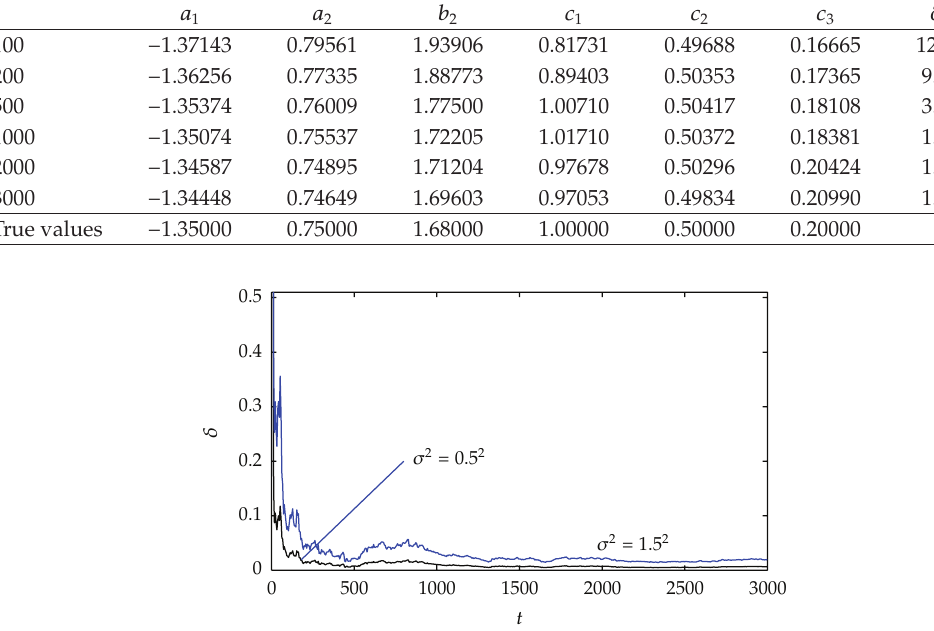
Figure 1: The parameter estimation errors δ versus t .